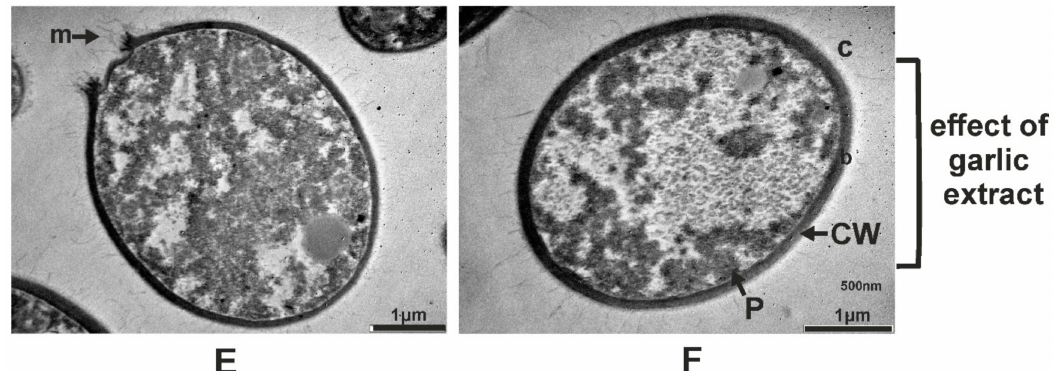
Figure 6. Transmission electron micrographs of R. mucilaginosa showing ultrastructural components of control cells: longitudinal section of bud and cell ( A,B,C ); longitudinal section of cell and bud (detailed) ( D ), and the changes produced by garlic extract in 14% minimum inhibitory concentration: longitudinal section of cell ( E ), cross section of cell ( F ). Legend: b, bud; c, cell; CW, cell wall; ER, endoplasmic reticulum; G, glycogen; L, lipid; M, mitochondrion; m, mucilage; N, nucleus; P, plasmalemma; V, vacuole.